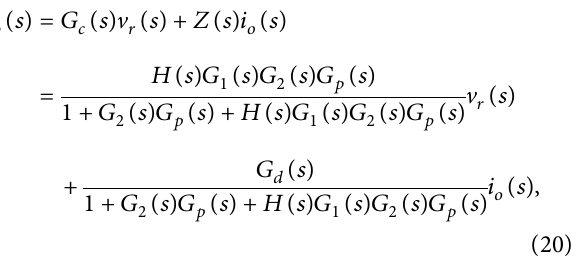
� 100, and ω � p (0.1 ≤ k p ≤ 1.5, k i c